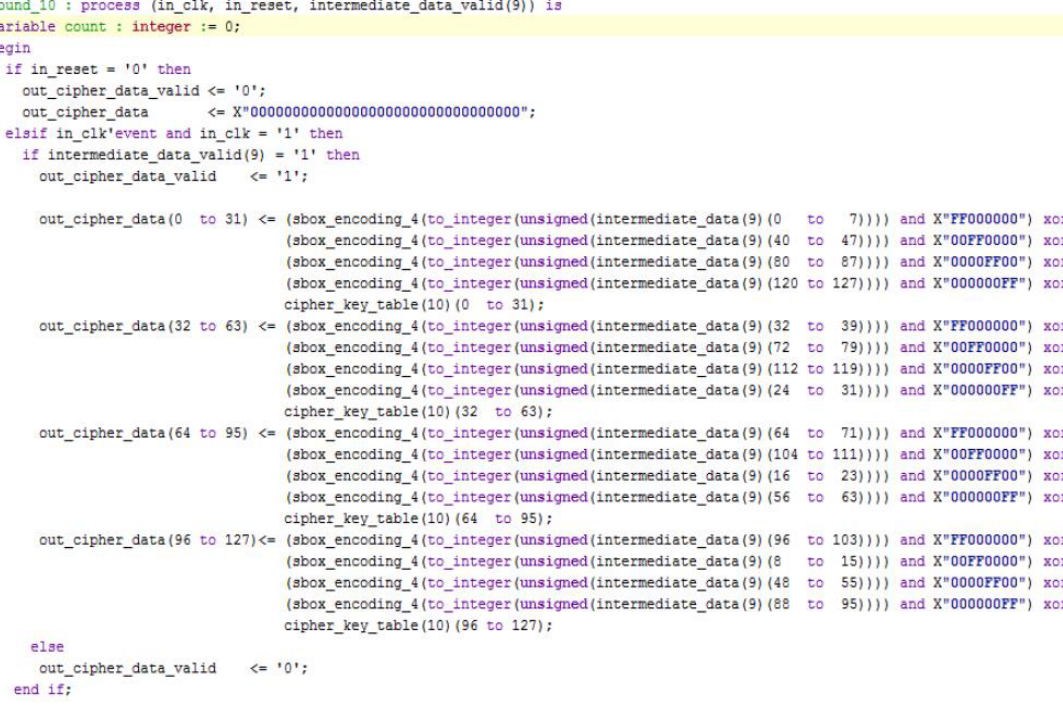
Figure 14. Code section related to the Add Round Key carried out in the last round (called round_10) of the AES-128 algorithm.